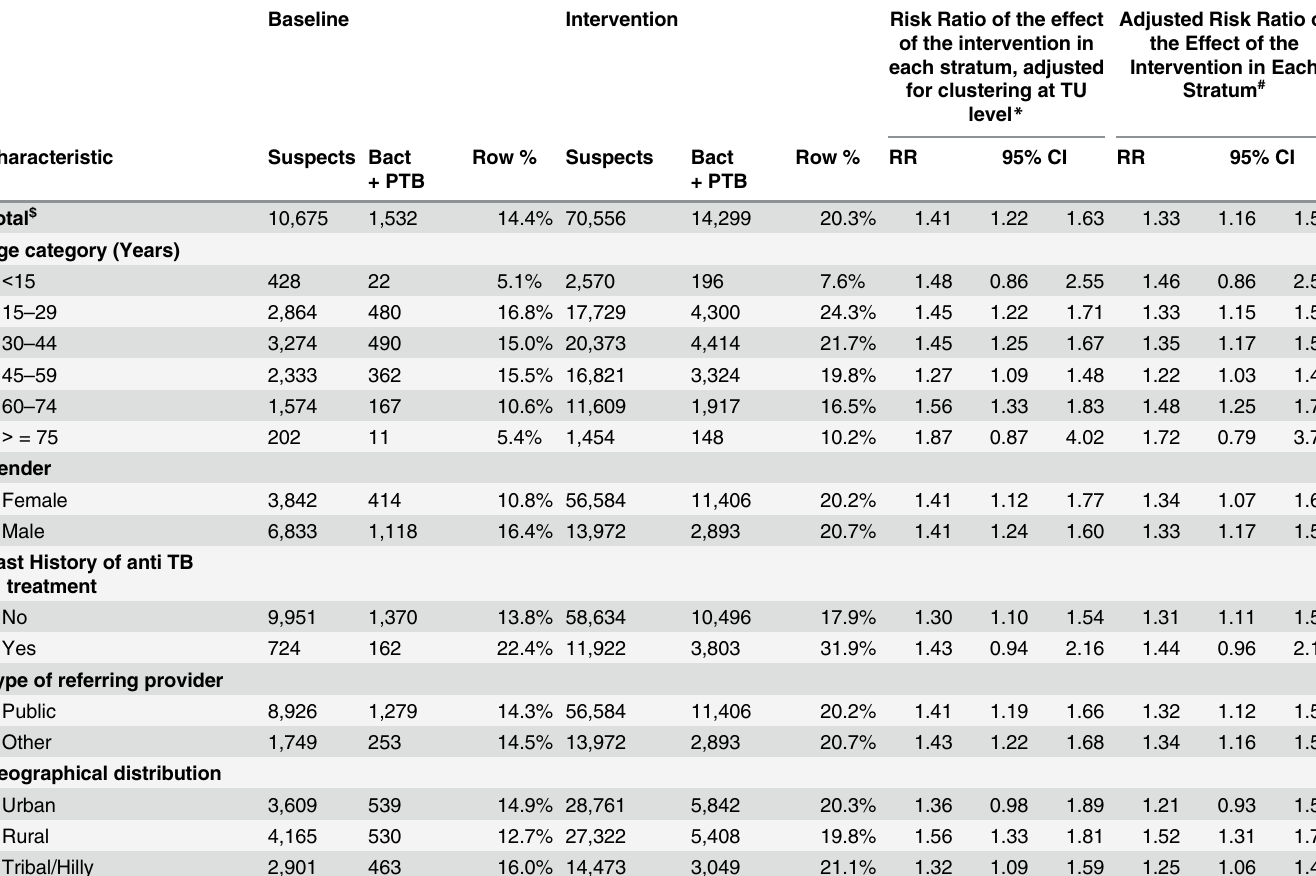
Table 3. Proportion of bacteriologically confirmed pulmonary tuberculosis cases diagnosed at the 14 study treatment units with data collection both in the baseline and intervention phase. Baseline